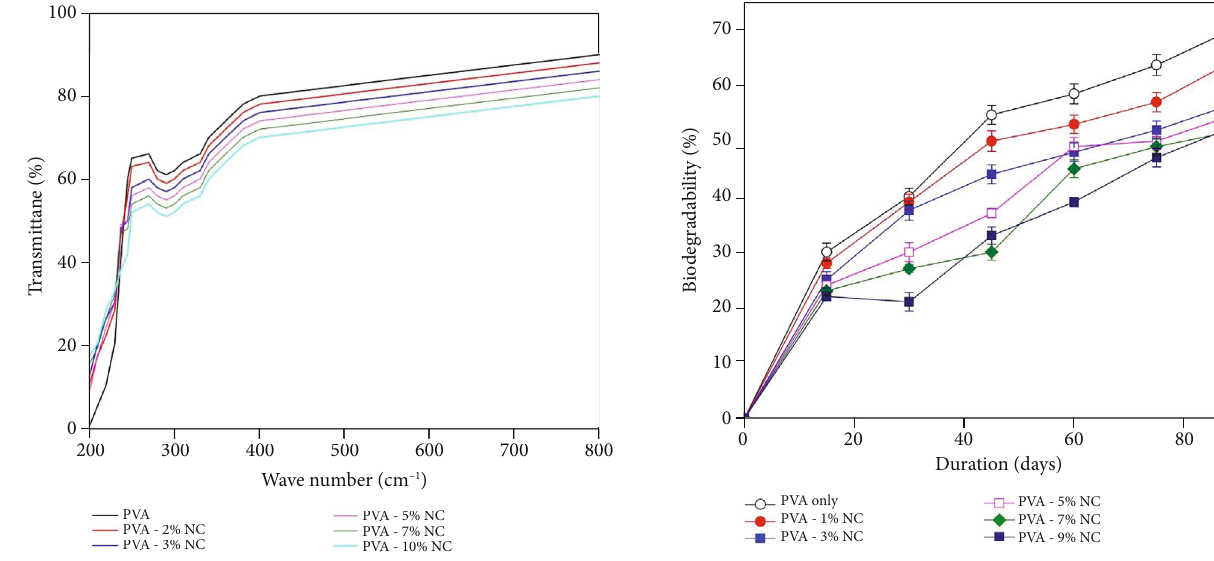
Figure 5: Result of UV-Vis spectrometer for neat PVA and PVA- NC composite fi lms.